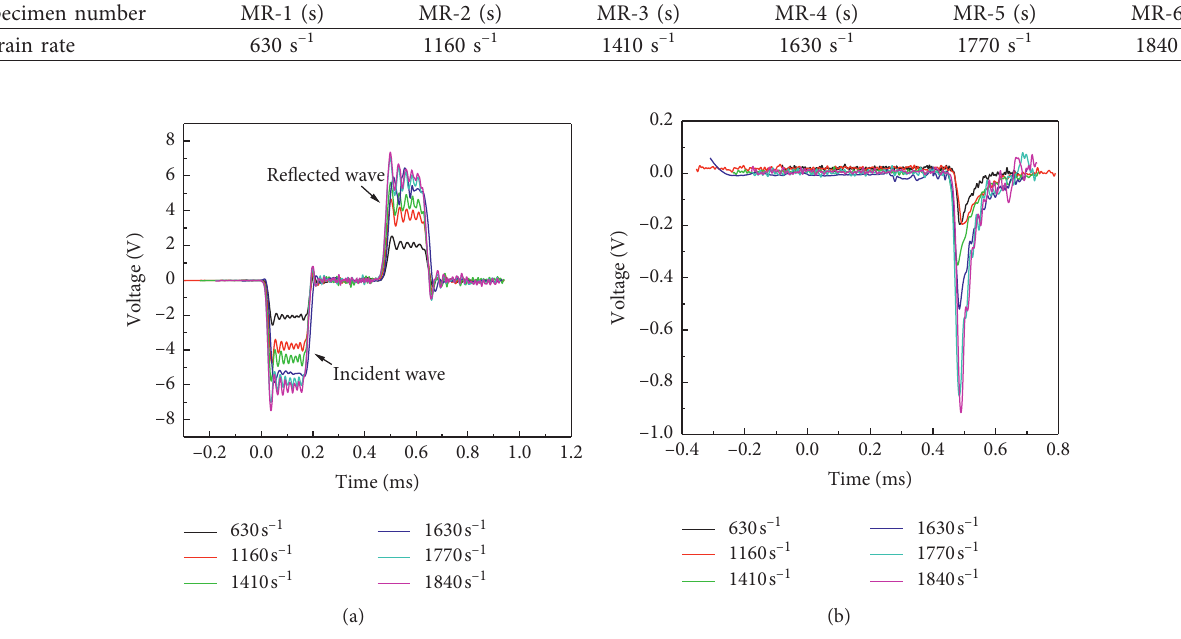
Figure 3: (a) Incident and reflected signals; (b) transmitted signals.